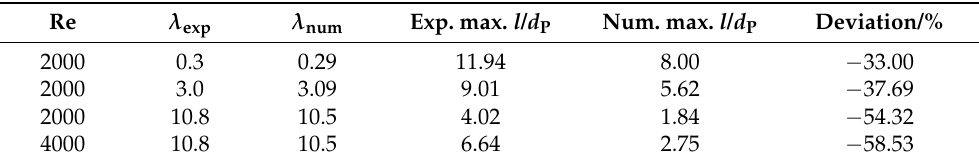
Table 4. Summary of the experimental and numerical results concerning drop elongation and its deviation for the different cases.